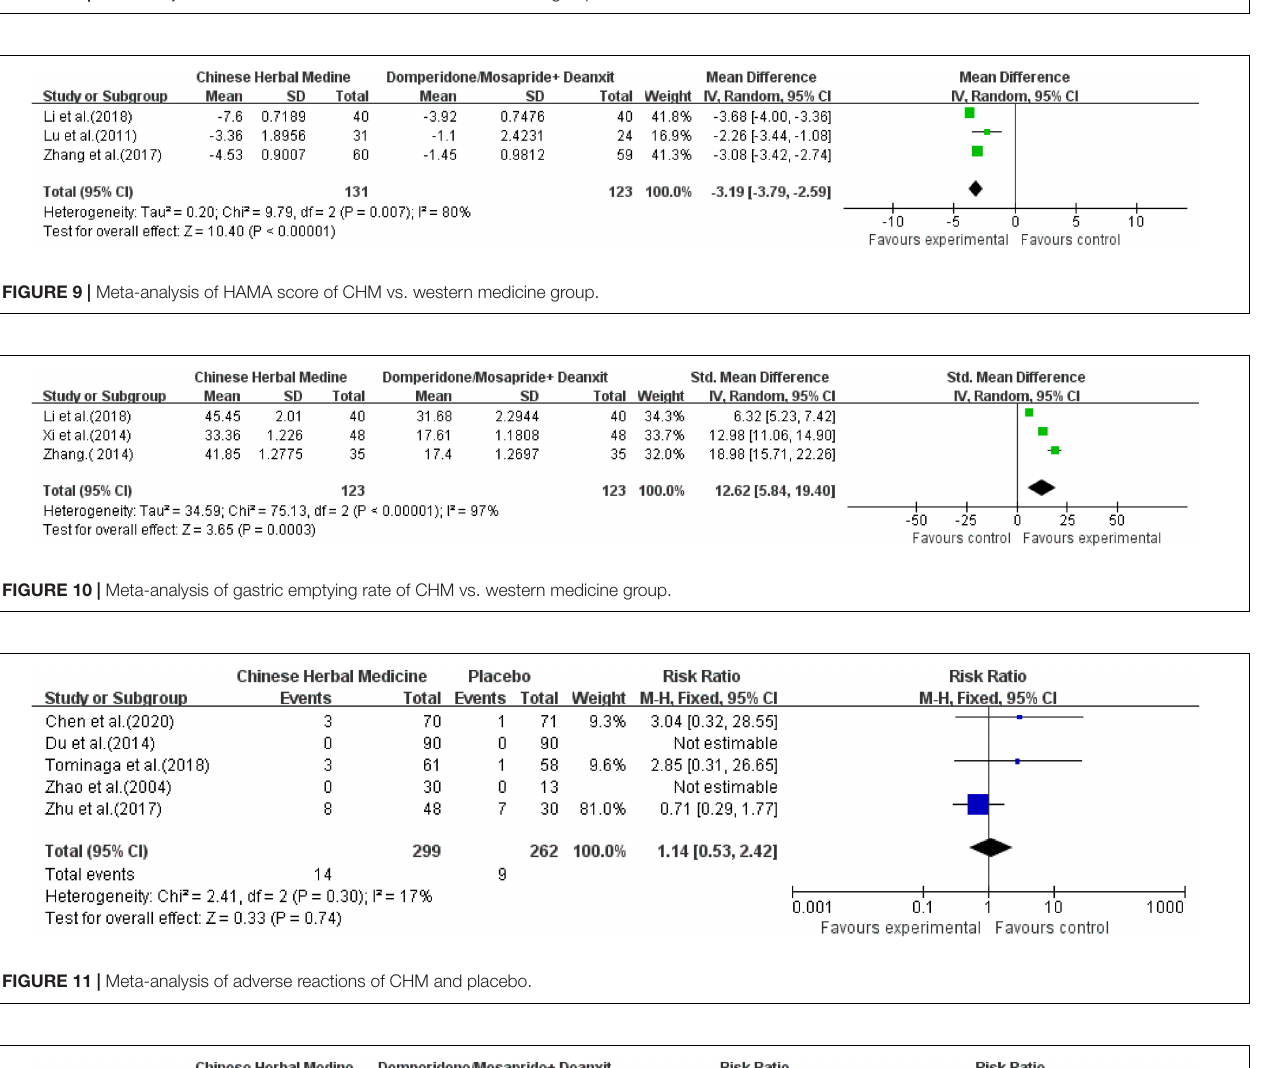
FIGURE 8 | Meta-analysis of HAMD score of CHM vs. western medicine group.